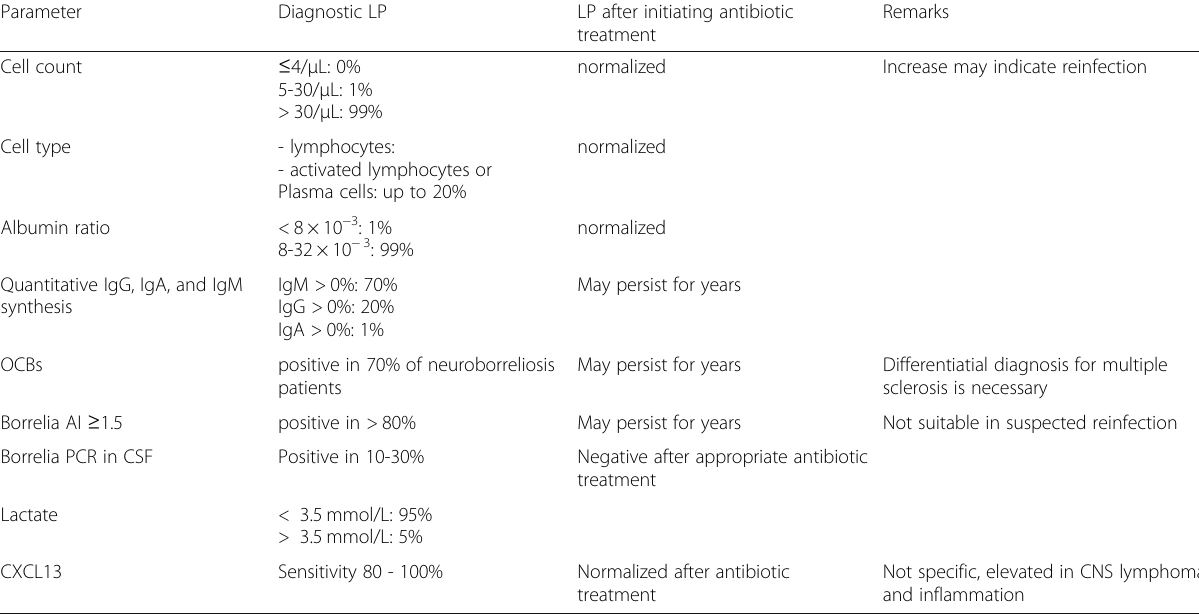
Table 7 CSF findings in patients with neuroborreliosis